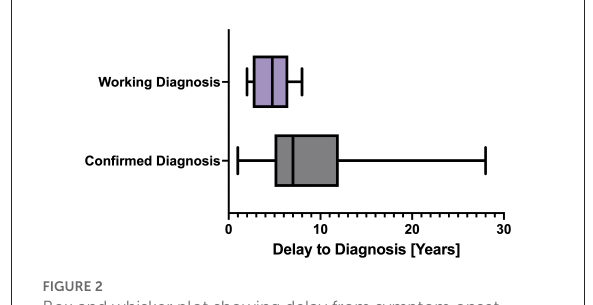
FIGURE2 Box and whisker plot showing delay from symptom onset to